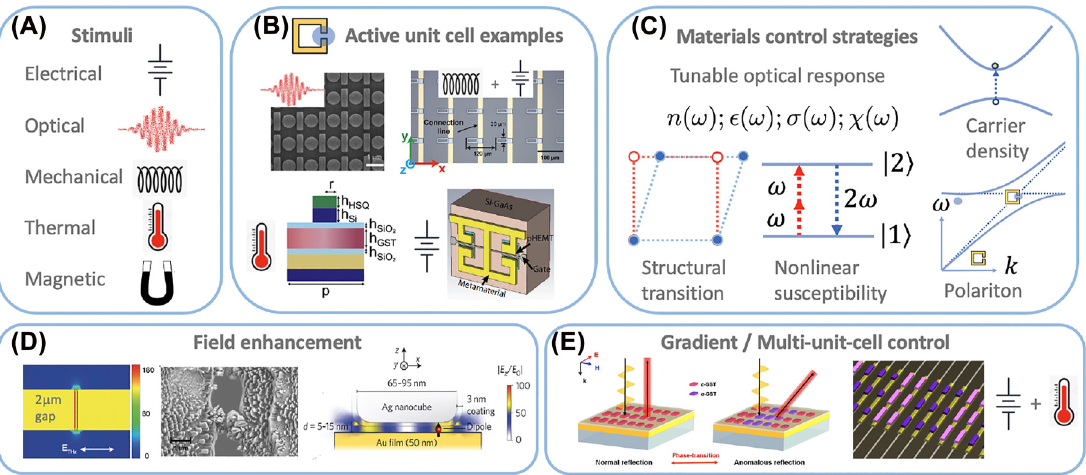
Figure 4: (A) Various stimuli to realize active metamaterial control. (B) Examples of unit cells amenable to active/nonlinear control. Upper left: Si bar-disk resonator which exhibits a field enhanced nonlinear response leading to an increase in the efficiency of high harmonic generation. Reprinted from [76], Copyright 2018, Nature Publishing Group. Upper right: a cantilever controlled metasurface to realize surface wave switching in the terahertz range. Reprinted from [77], Copyright 2022, Optica. Lower left: a near-IR plasmonic metamaterial where thermal control is achieved using GST. Reprinted from [78], Copyright 2021, ACS. Lower right: terahertz split ring resonator with HEMT integration for high frequency modulation. Reprinted from [79], Copyright 2011, Optica. (C) Materials integration enables control through of the dielectric response. This includes structural control, carrier doping, nonlinear effects, and polaritonic tuning. (D) Metasurface gap structures provide large on-resonance electric field enhancement and localization (left simulation) which can play an important role in nonlinear active metamaterials. (D) Middle panel shows an image of metamaterial gap structure demonstrating electromigration due to the large electric field concentration. Left and center image: Reprinted from [80], Copyright 2015, AIP. Right image: Reprinted from [81], Copyright 2014, Nature Publishing Group. (E) Active control can also be realized at the unit-cell level to tune the gradient/phase response of metasurfaces – the example depicted here is current-based thermal control of GST.Reprinted from [87], Copyright 2021,